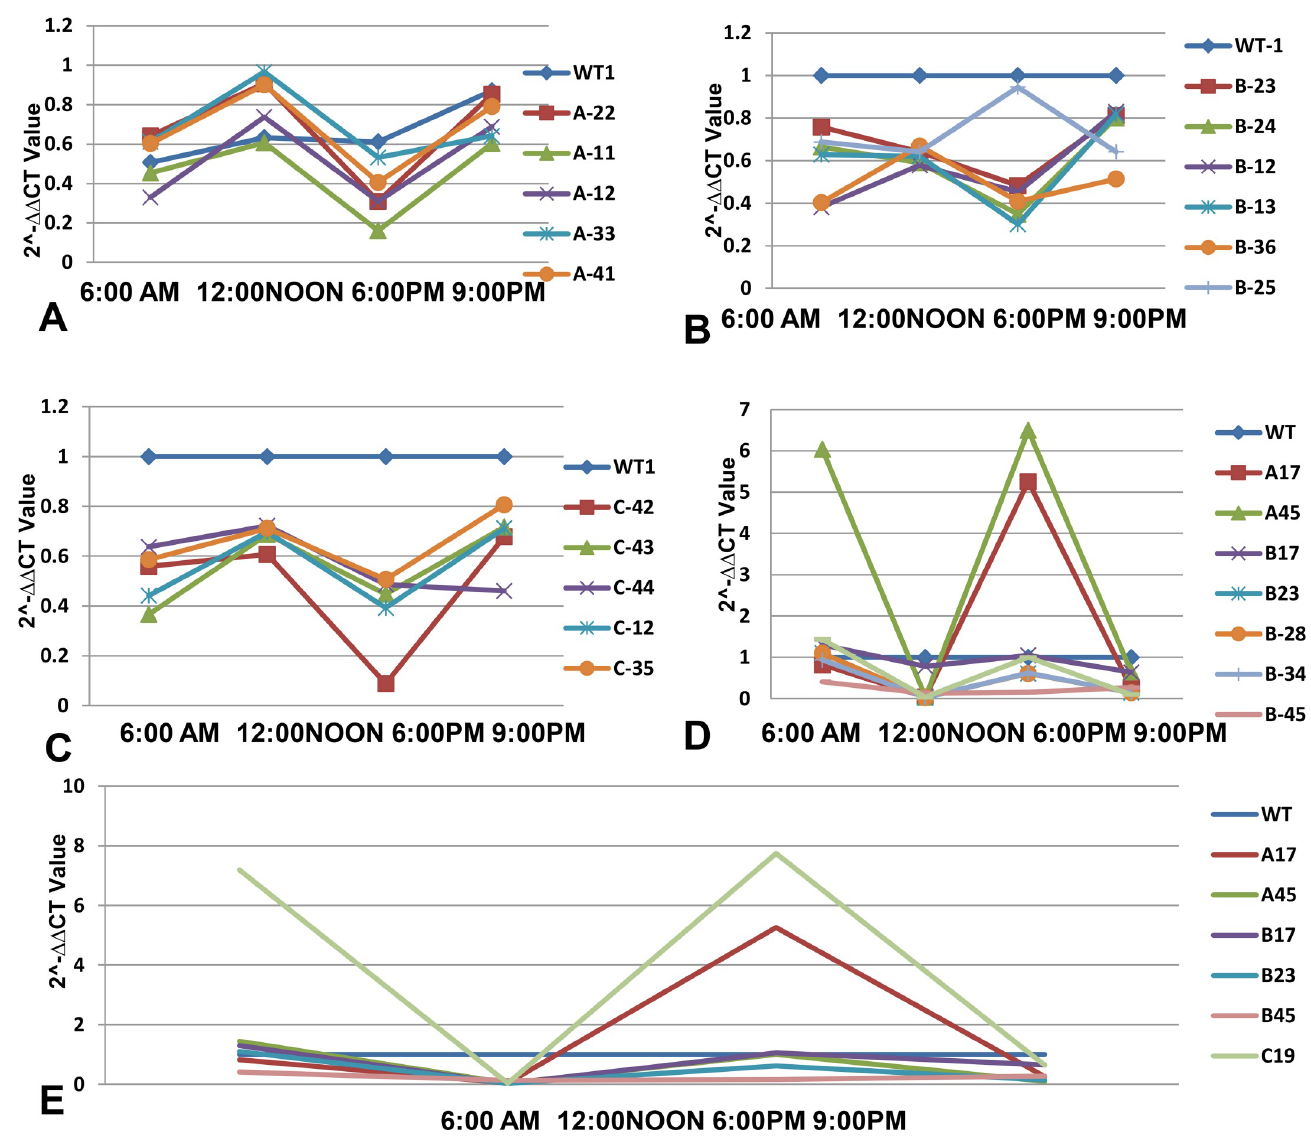
Fig 7. The qRT-PCR expression analysis of CCA1 gene in T0, T1 and T2 transgenic rice plants at different time points; 6:00AM, 12:00 Noon, 6:00 PM and 9:00 PM. The relative fold change expression of CCA1 gene was monitored as per 2 - ΔΔ CT method by taking wild type as a calibrator. (A, B, C) CCA1 gene expression in T0 derived transgenic plants of construct A, B and C (D) CCA1 gene expression in T1 derived transgenic plants of construct A, B and C (E) CCA1 gene expression in T2 derived transgenic plants of construct A, B and C.